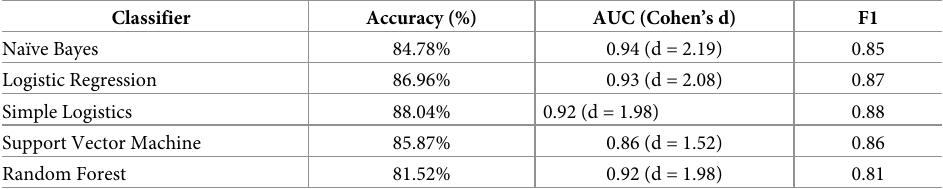
Table 6. Accuracies as measured by % correct, AUC and F1 obtained by five different ML classifiers.